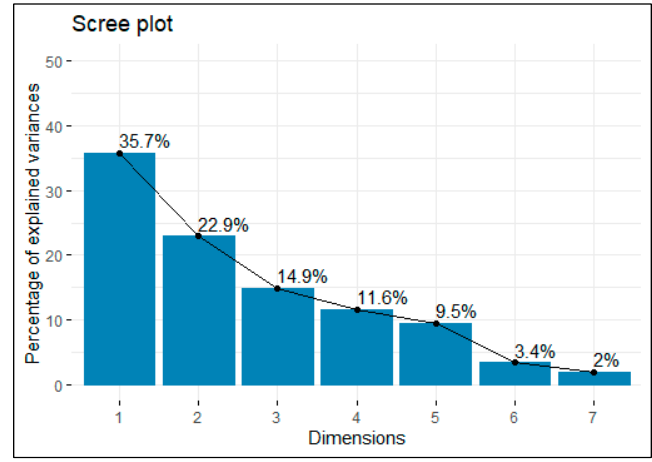
Figure 1. Scree plot of the variance of the components. Table 5. Summary of importance of principal components.